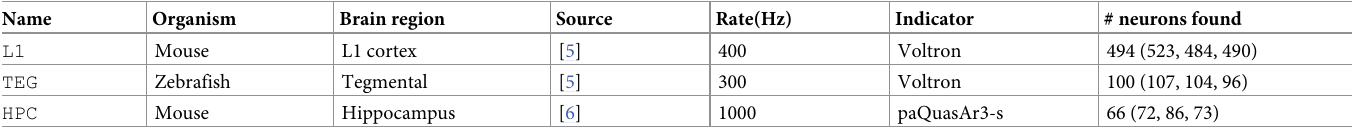
Table 1. Properties of three heterogeneous types of datasets. For each type of dataset the name, organism, brain region, source, imaging rate, voltage indicator, and total number of neurons selected by the manual annotators in GT (consensus, (labeler 1, labeler 2, labeler 3)) are